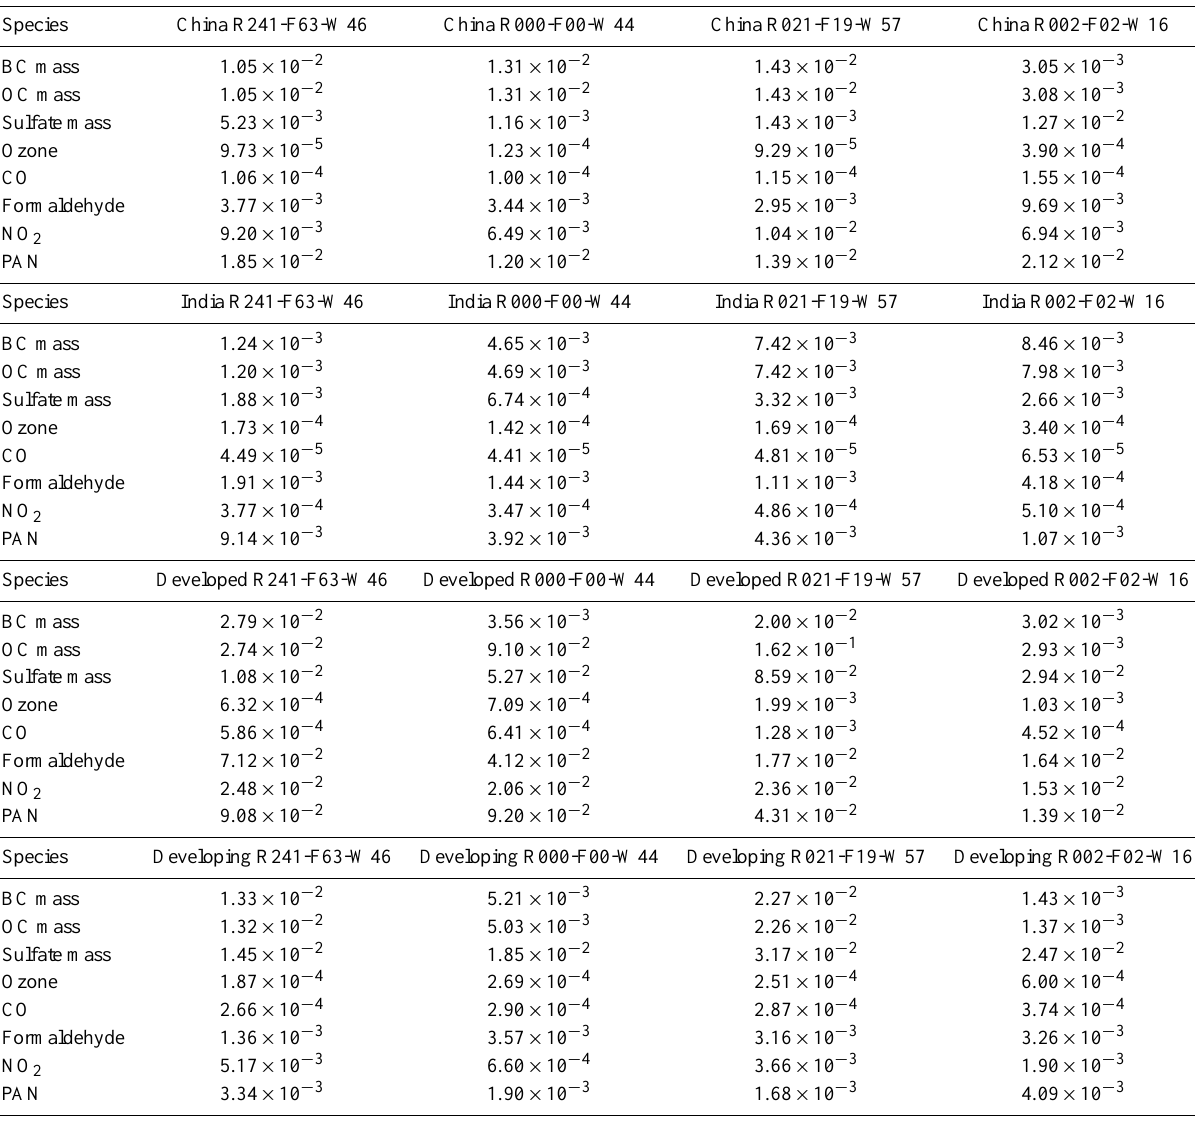
Table 6. Normalized fractional RMS errors for species mole